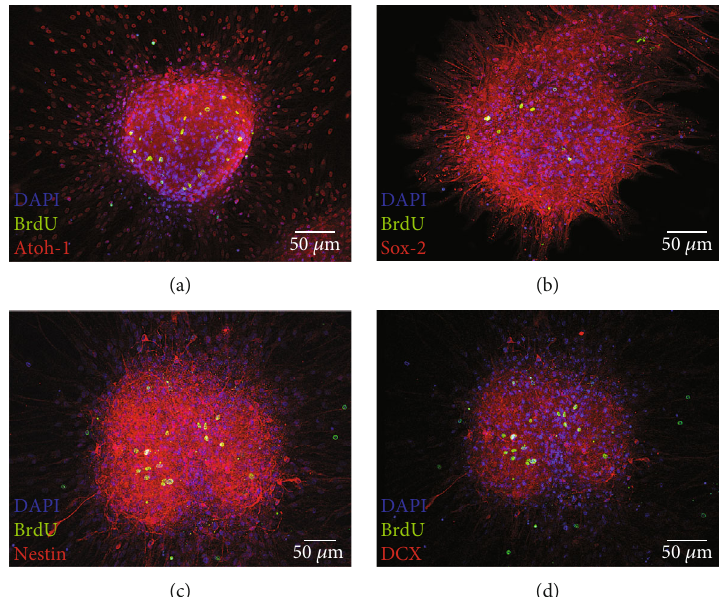
Figure 3: Generation of neural progenitor cells and stem cell division within neurospheres incubated with BrdU (10 μ M) in NSC medium for 24h on glass coverslips. Mitotic cells were indicated by BrdU incorporation (green). Cell nuclei were stained blue by DAPI. Neural progenitor cell markers could be identi fi ed and were stained red. Atoh1 was detected in the nucleus, whereas Sox-2, Nestin, and doublecortin (DCX) showed staining in the somata of the cells.